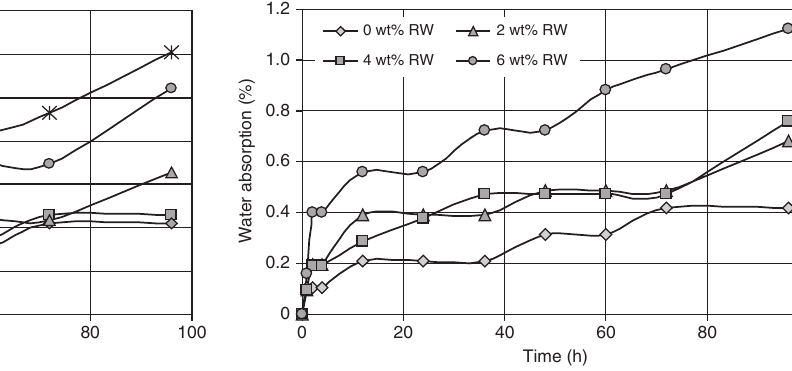
Figure 6 WA as a function of soaking time for different weight percentages of coconut fiber in